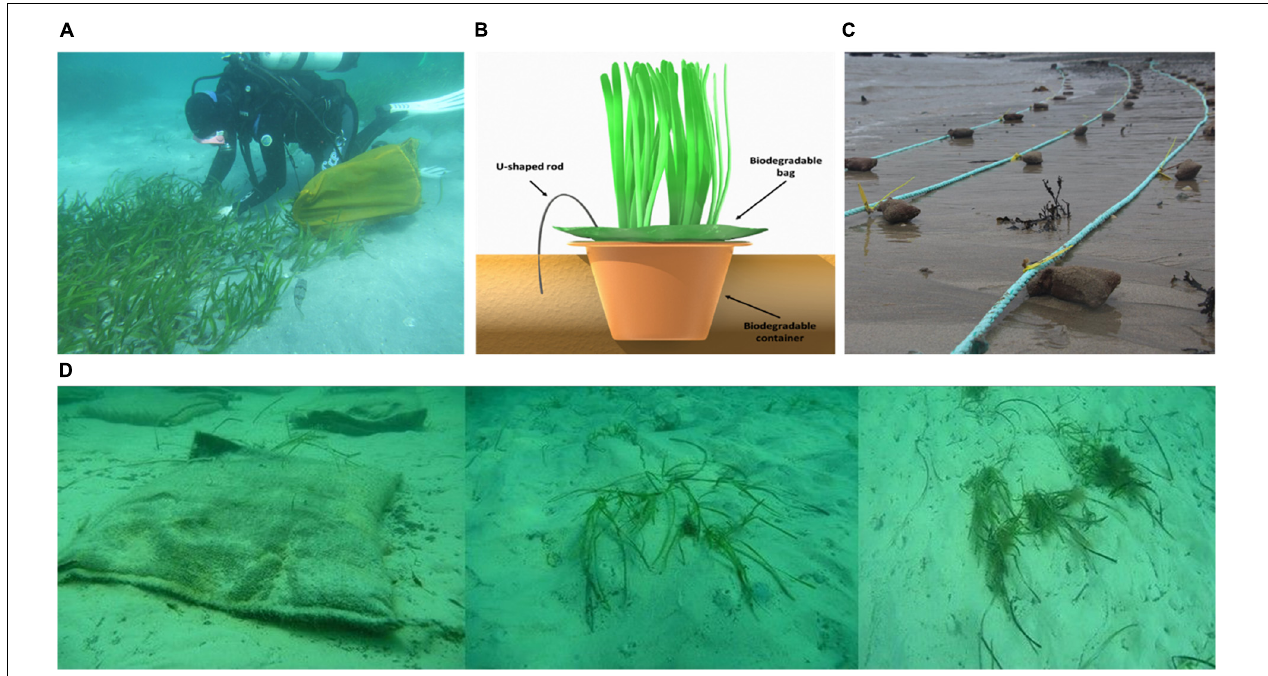
FIGURE 1 | (A) Seagrass transplant, ©Project SEAGRASS.LI (photos by Chris Pickerell, Cornell Cooperative extension of Suffolk County, NY); (B) seagrass transplant with biodegradable container (da Ros et al., 2021); (C) seagrass planting with hessian seed bags, ©Project Seagrass (photo taken in Porthdinllaen, Wales); (D) the germination and growth of hessian seed bag, ©SARDI (photos by Jason